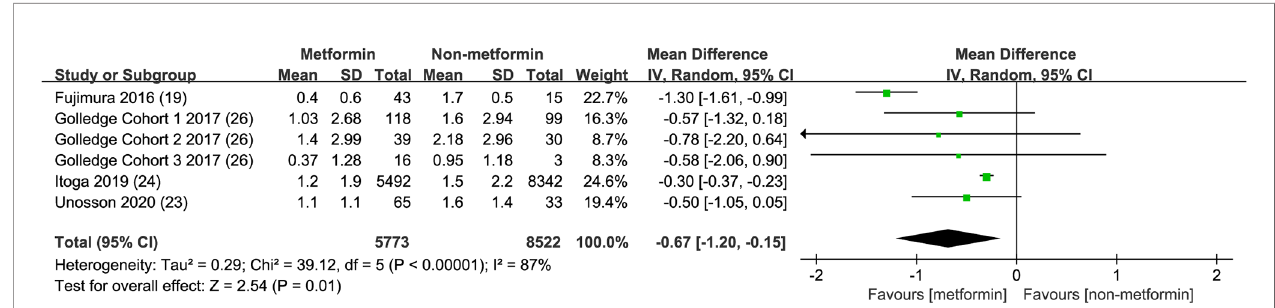
FIGURE 5 | Assessment of the effect of metformin on annual AAA growth rate. Forrest plot of studies assessing the effect of metformin on annual AAA growth